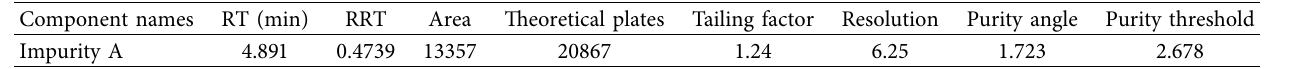
Table 6: System suitability parameters for impurity A in NMS injection.